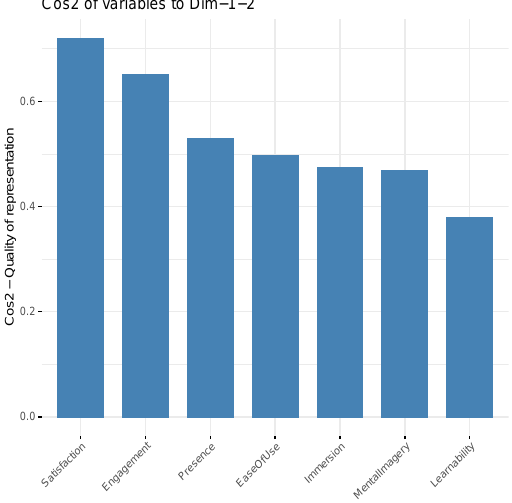
Figure 10. Quality of representation of user experience factors.